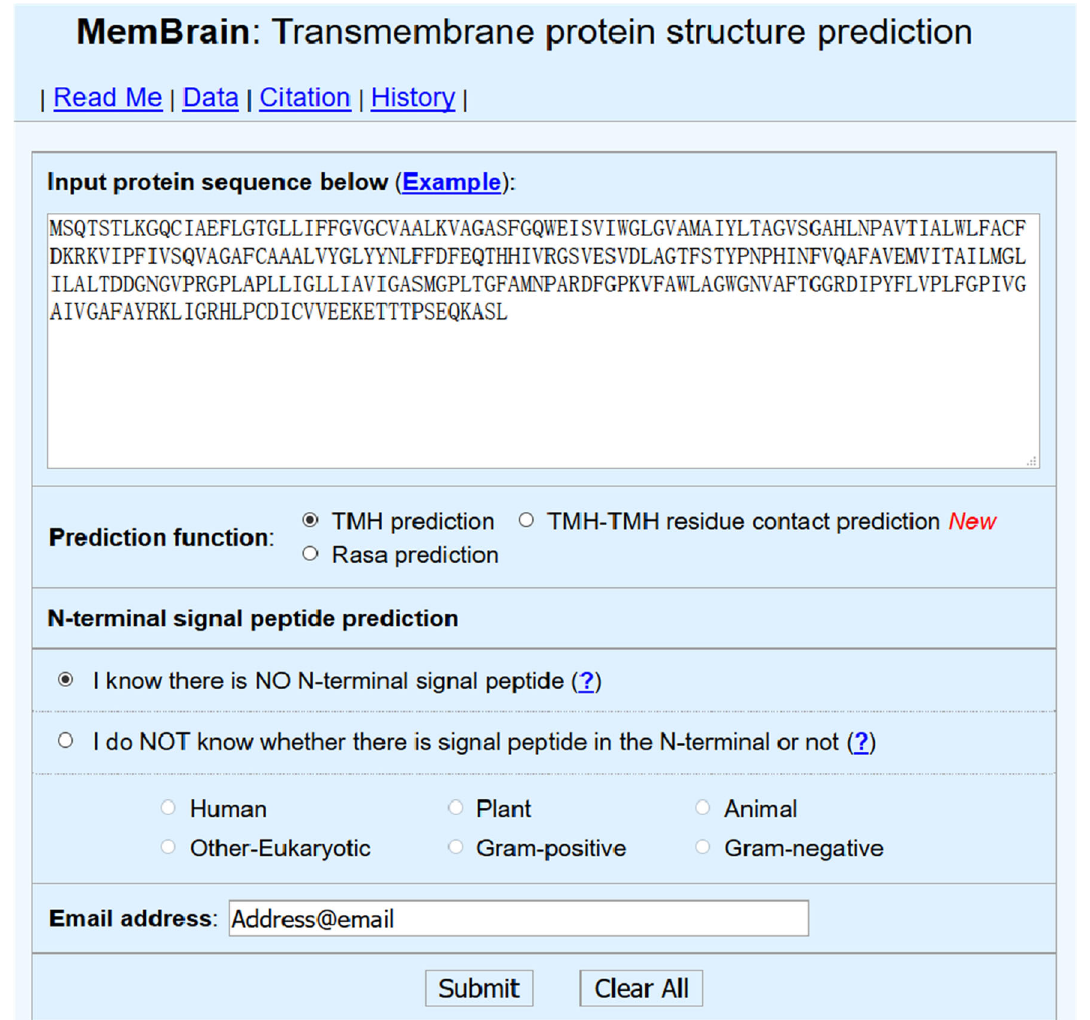
Fig. 2 A screenshot of the submission interface of MemBrain web server